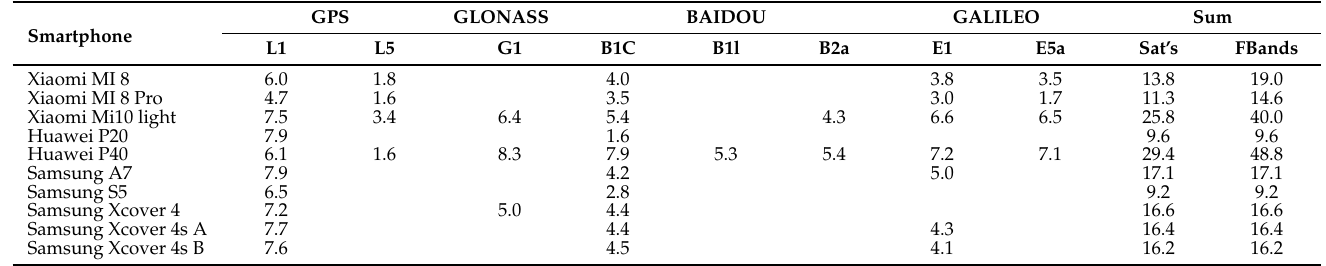
Table 3. Number of active satellites used for fixed positions per constellation and frequency bands (FBand) given as an average over the entire data collection